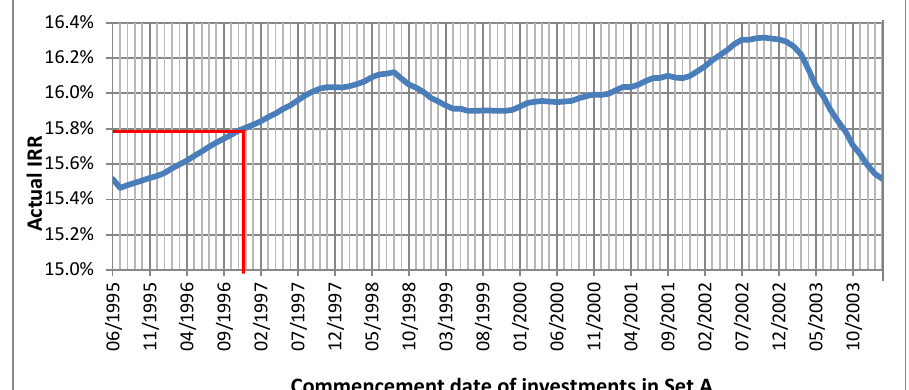
FIGURE 3: IRRs generated by the investments of Set A Source: Authors’ deductions